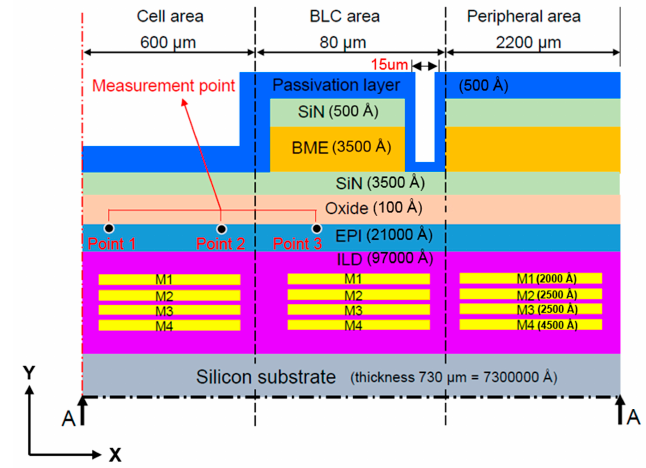
Figure 8. Side view (x-y plane) of Structure B showing the section of the stacked-film architecture along the line A–A.